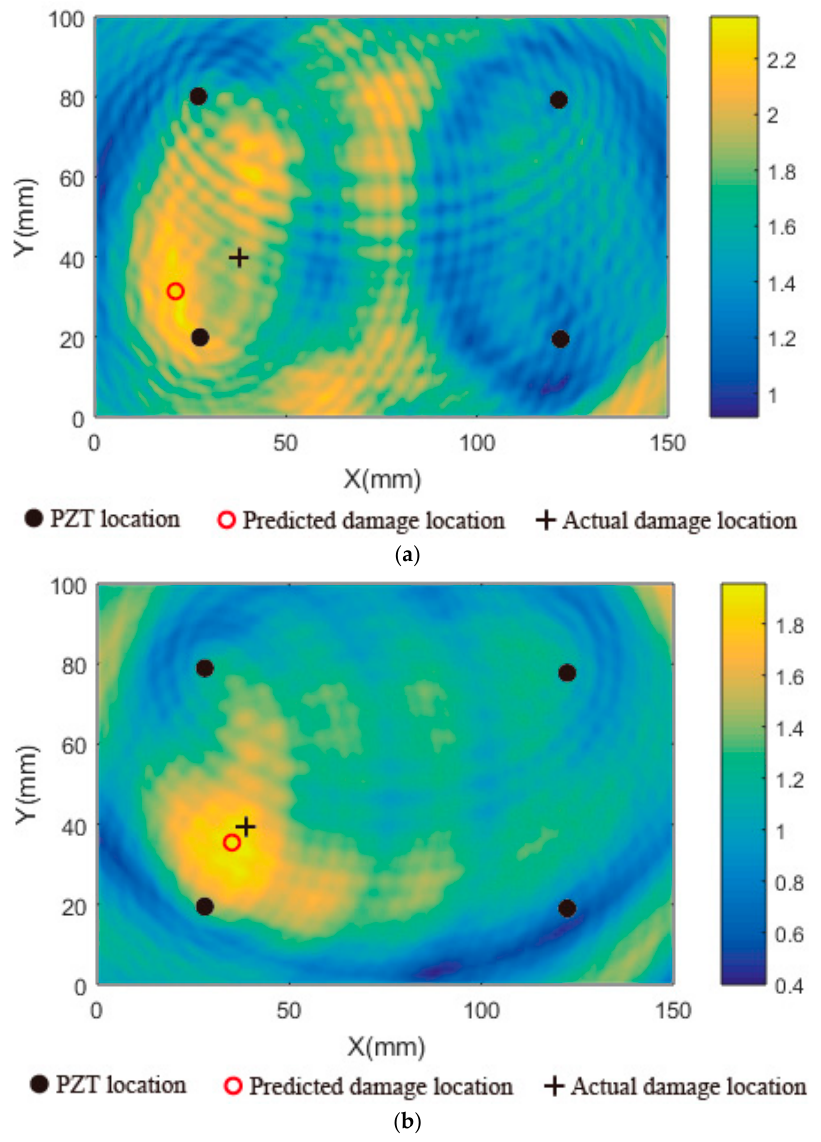
Figure 12. Damage imaging results: ( a ) Imaging result without temperature compensation; ( b ) Imaging result with temperature compensation.